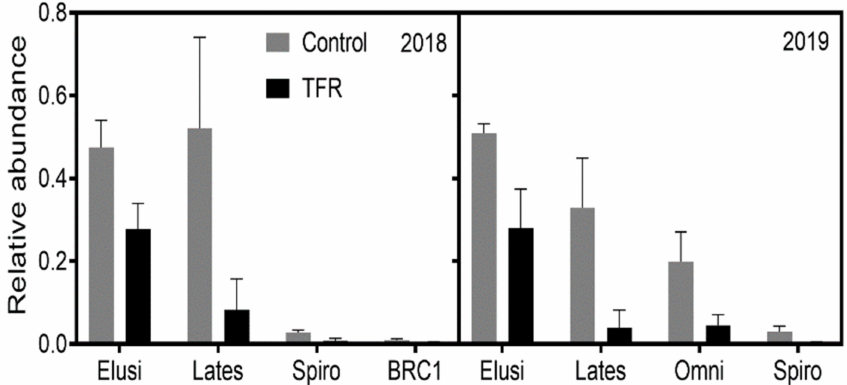
Figure 2. Relative abundance of bacterial phyla that showed a significant ( p < 0.05) response to the TFR in 2018 and 2019. Elusi, Elusimicrobia; Lates, Latescibacteria; Spiro, Spirochaetes; BRC1, BRC1; Omni,